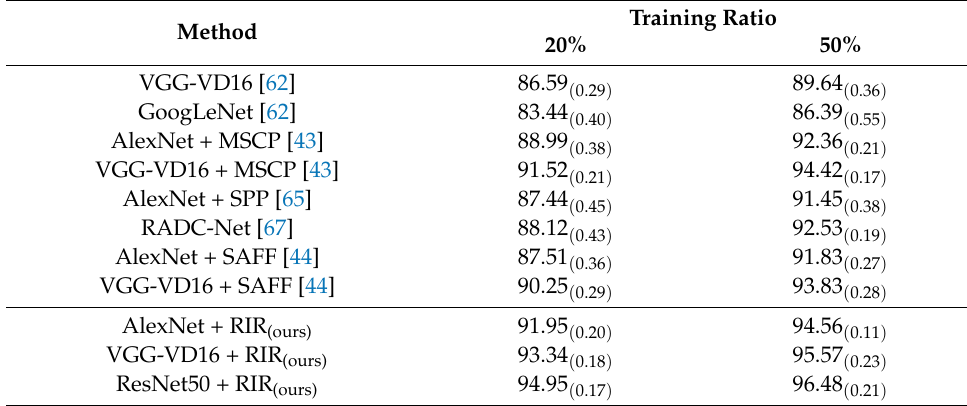
Table 9. Comparison of the OAs (%) on the AID dataset (training ratio = 20% and